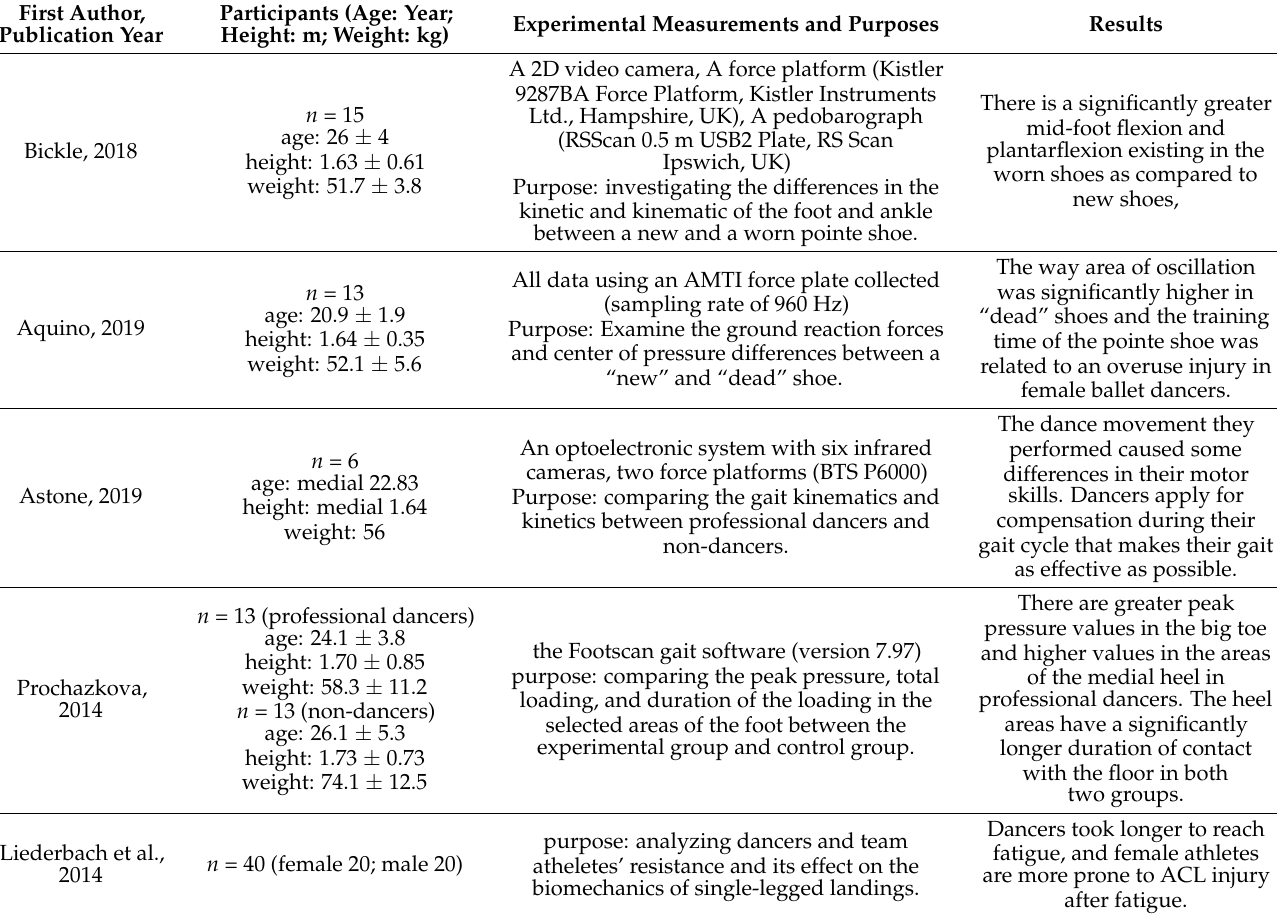
Table 2. The characteristics and results of included